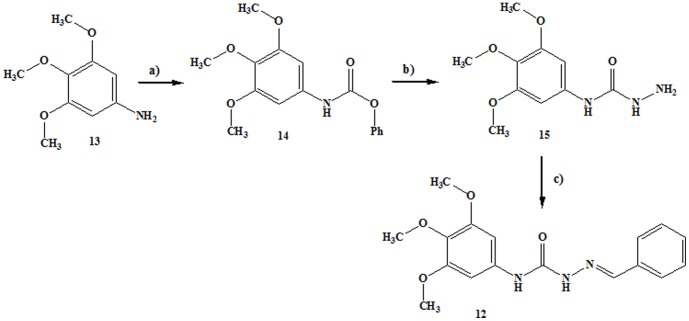
Conditions and reagents: a) Phenyl chloroformate, CHCl3, reflux, 2 h, 47%; b) N2H4.H2O, toluene, r.t., 72 h, 64%; c) PhCHO, EtOH, HCl (cat), r.t., 1 h, 83%.